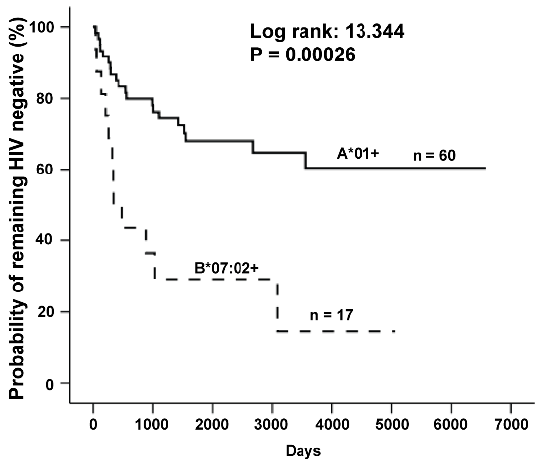
Figure 1. Kaplan-Meier plot of time to HIV-1 seroconversion. Comparison of A*01+ and B*07:02+ female sex workers. sex